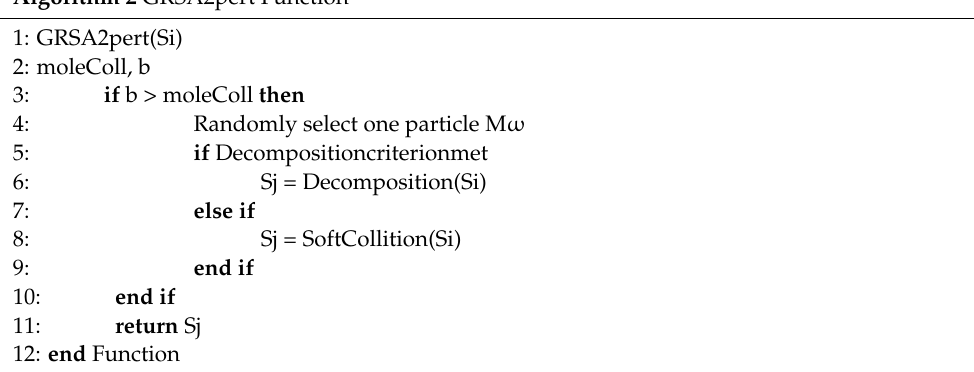
Algorithm 2 GRSA2pert